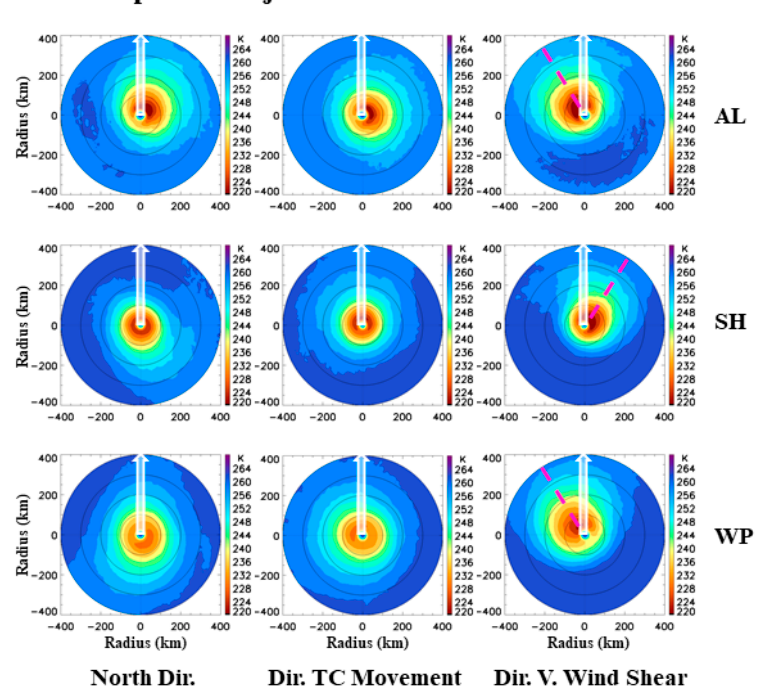
Figure 12. Comparison of the composite TB distributions at 89H GHz for major hurricanes over AL, SH and WP. Left, middle and right panel is for composition with regard to northward, direction of TC movement, and direction of the 200–850 hPa wind shear, respectively. White arrow is direction of the composition method for each panel. The red dashed line in the right panel is for axis of the minimum TBs.